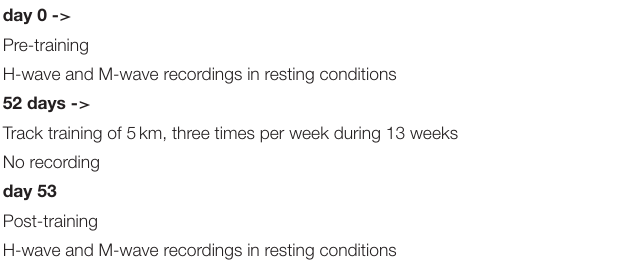
TABLE 3 | Timeline for the measurements (duration of the training, and pre- post-training). day 0 - >